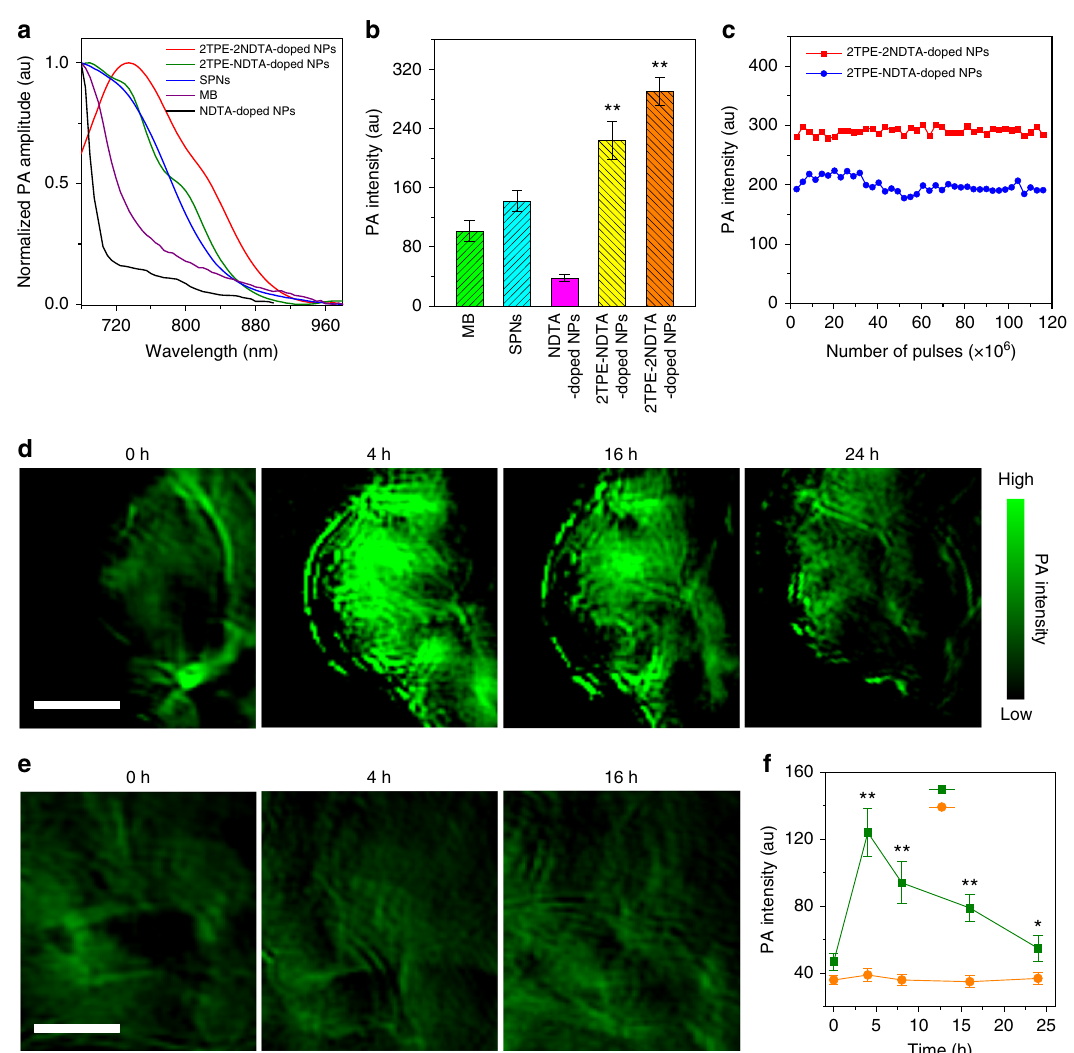
Fig. 5 PA property and in vivo PA imaging with iMIPT NPs. a PA spectra of various NPs indicated. b PA signal (excited by 680 nm pulsed laser with a laser fl uence of 17.5 mJ cm − 2 and a repetition rate of 10 Hz) comparison of different agents at the same concentration of 25 μ M based on NDTA, 2TPE-NDTA, 2TPE-2NDTA, MB, and the repeat unit of semiconducting polymer. Error bars, mean ± s.d. ( n = 3). ** P < 0.01, in comparison between 2TPE-2NDTA-doped NPs or 2TPE-NDTA-doped NPs and other 3 agents (NDTA-doped NPs, SPNs, and MB) using one-way ANOVA. c Plot of PA intensities of 2TPE-2NDTA- doped and 2TPE-NDTA-doped NPs in phantoms against number of laser pulses at 730 nm. The total laser exposure time was 800 ms for 1.16 × 10 8 pulses. d , e Representative PA images of d tumours and e muscles from 2TPE-2NDTA-doped NP-administrated mice. Before (0 h) and after